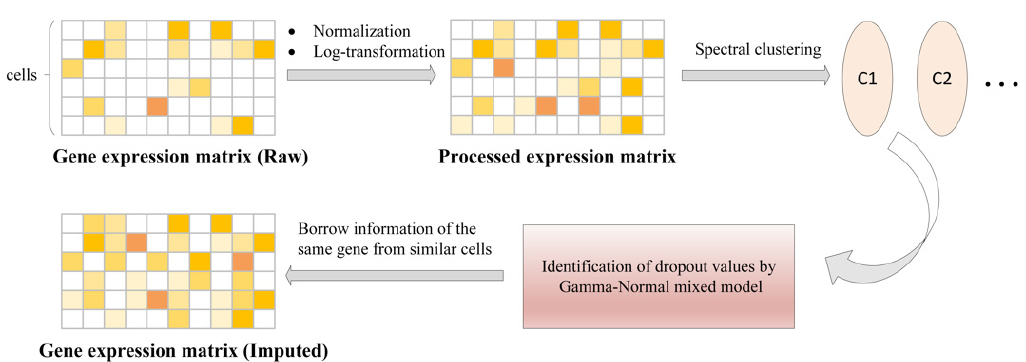
Figure 5. The framework of scImpute method